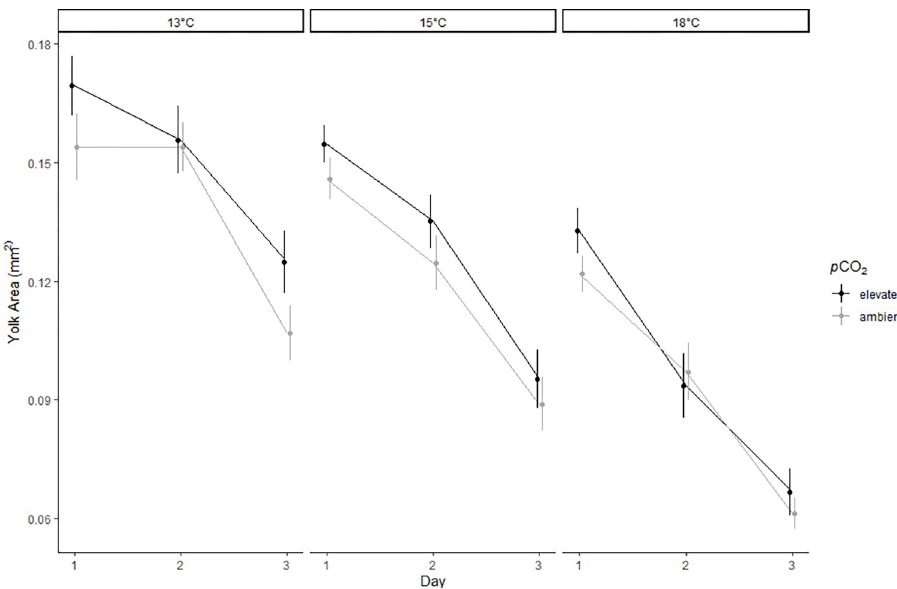
Fig 2. Larvae yolk usage. Yolk sac area of surf smelt larvae (n = 144/ day) that were submerged in treatment water for 3 days. Data are averages representative of the temperature treatment, p CO 2 treatment (points offset for visualization), and day with standard error shown as whiskers. Day, and Temperature were significant factors predicting larvae yolk